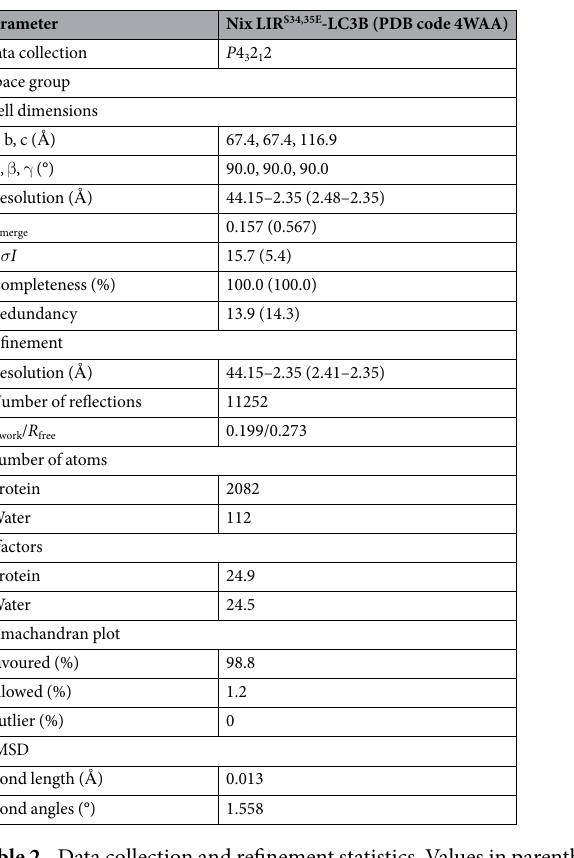
Table 2. Data collection and refinement statistics. Values in parentheses are for the highest-resolution